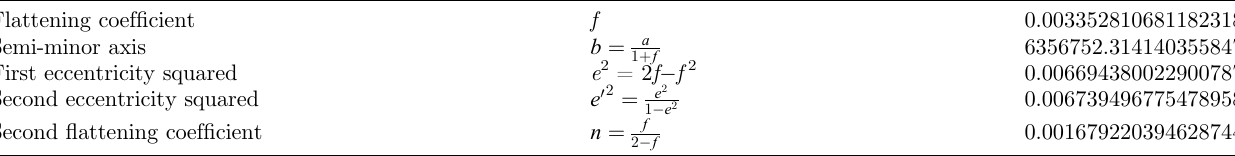
Table A-2. Geometric parameters of the GRS80 ellipsoid.